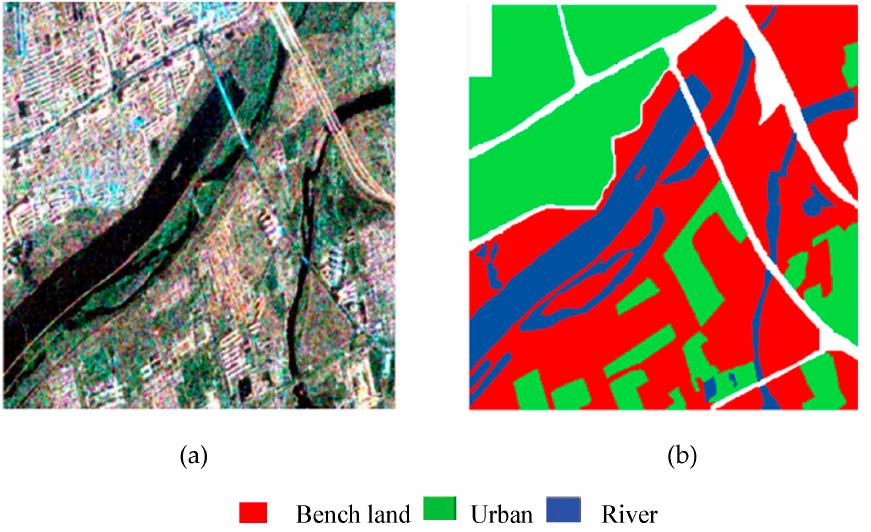
Figure 8. RADARSAT-2 data in Xi’an : ( a ) Pauli image. ( b ) Ground-truth image.